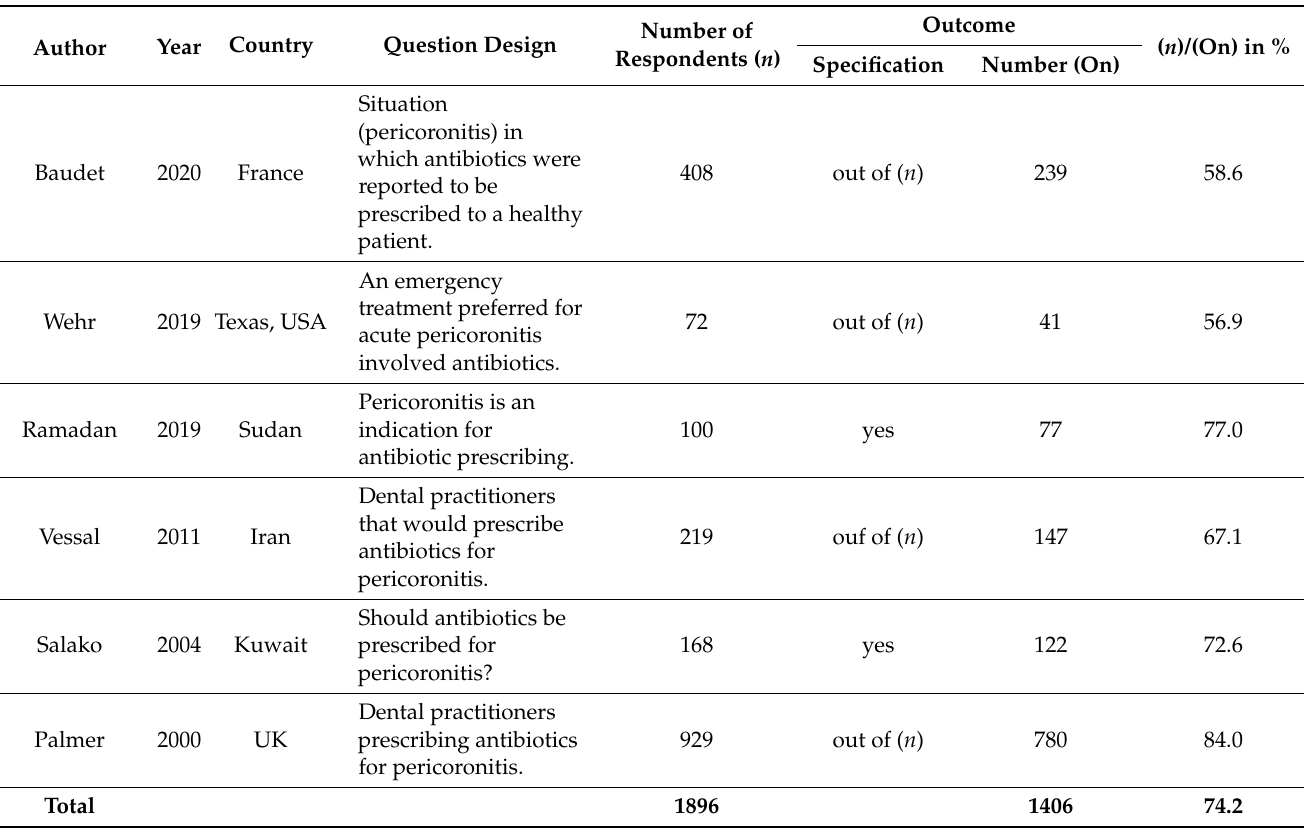
Table 6. Questionnaires among dentists regarding the antibiotic prescribing for pericoronitis.